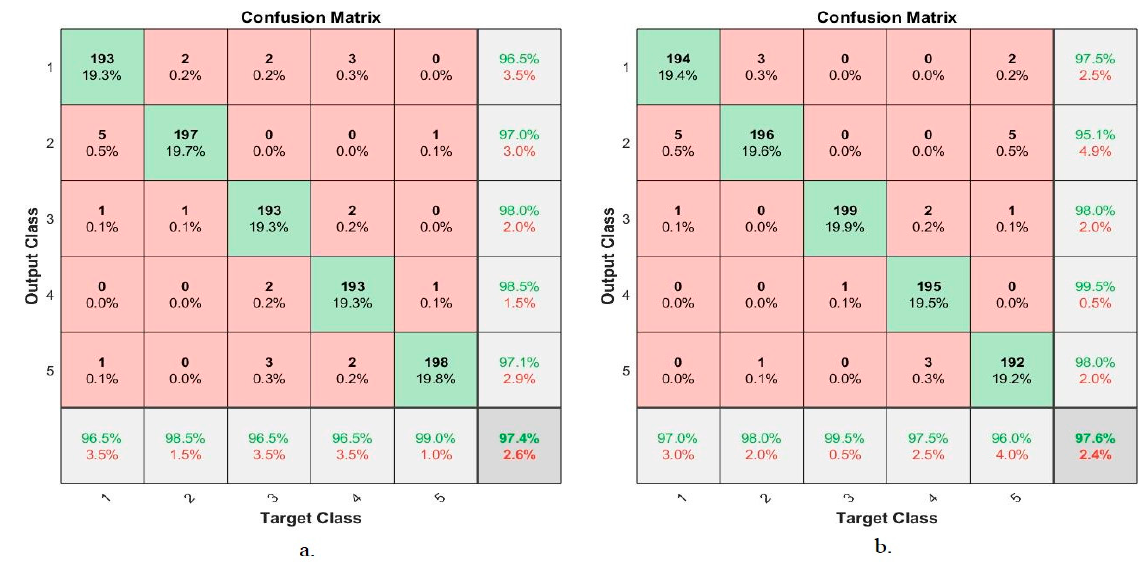
Table 2. The results of the ANN and FFNN algorithms on the gastroenterology dataset.